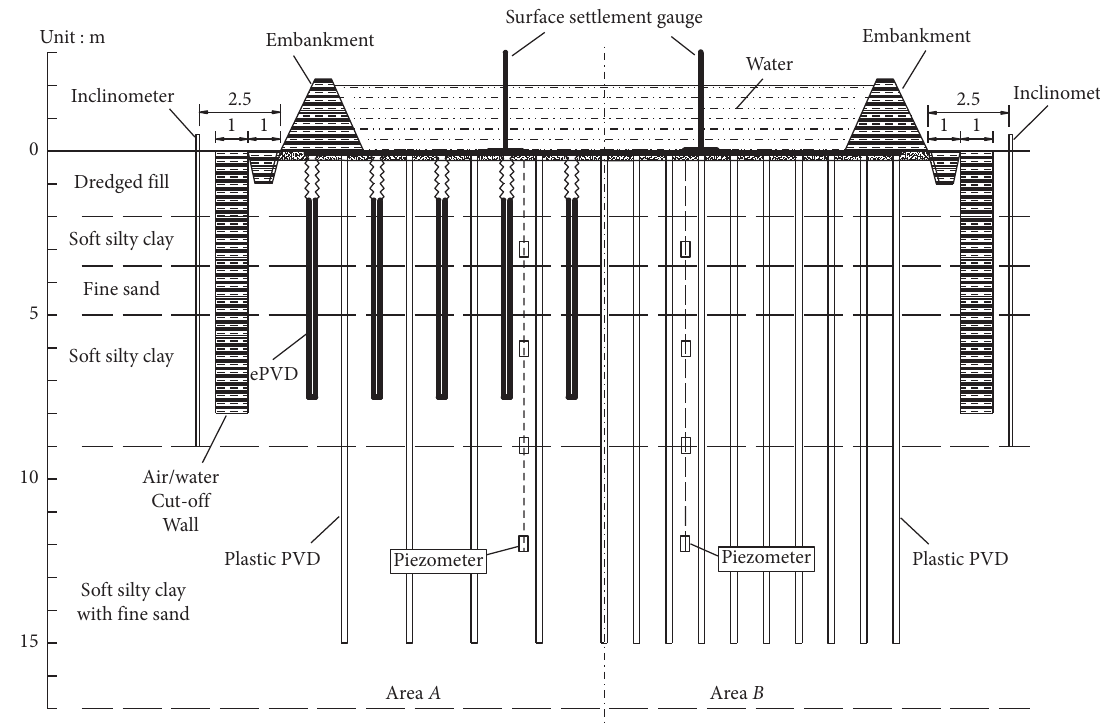
Figure 3: Vacuum seal and drainage